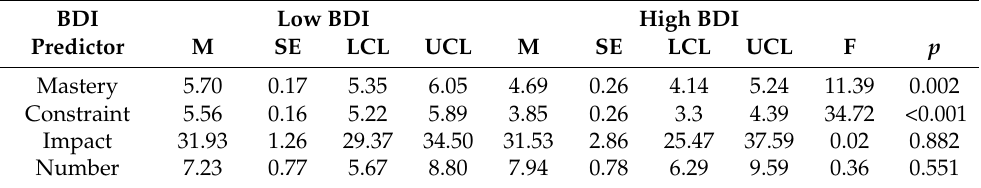
Table 3. Summary of predictor variable means for low and high BDI participants. BDI Low BDI